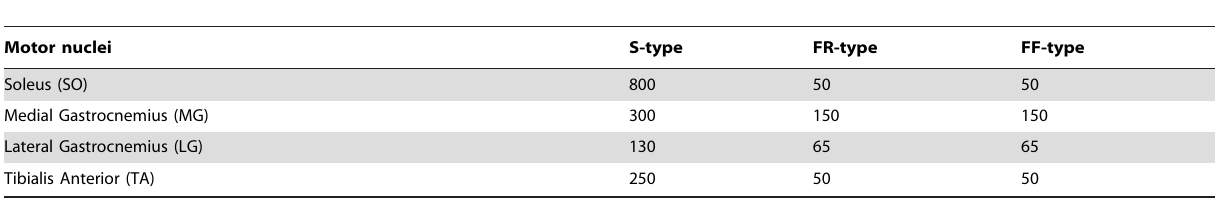
Table 2. Number and types of spinal motor neurons (MNs) adopted for each motor nuclei represented in the model.